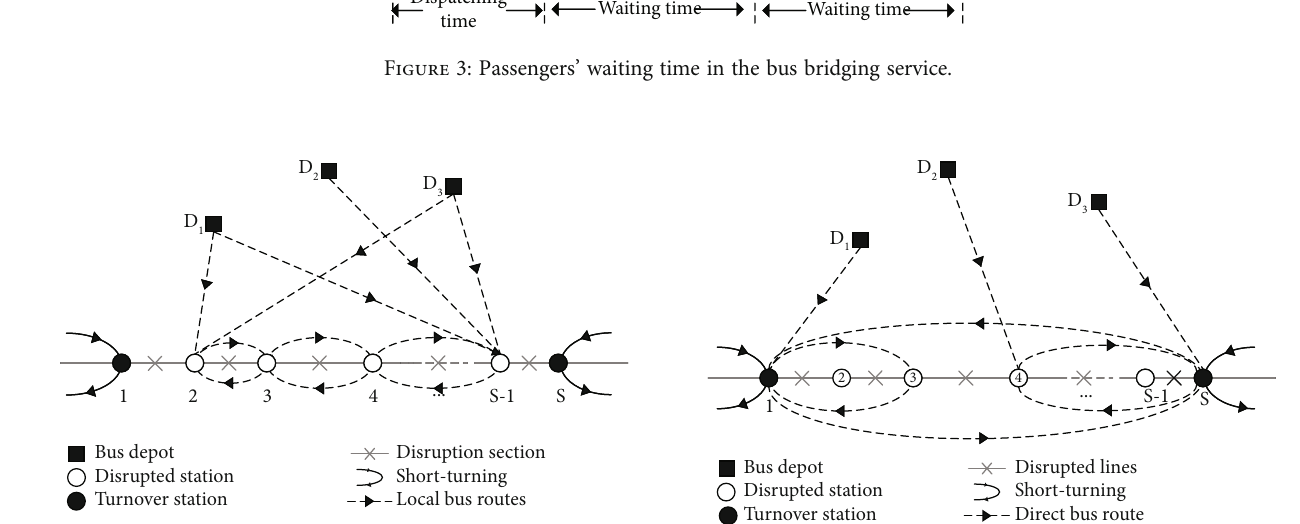
Figure 5: The direct bus routes (DBR).